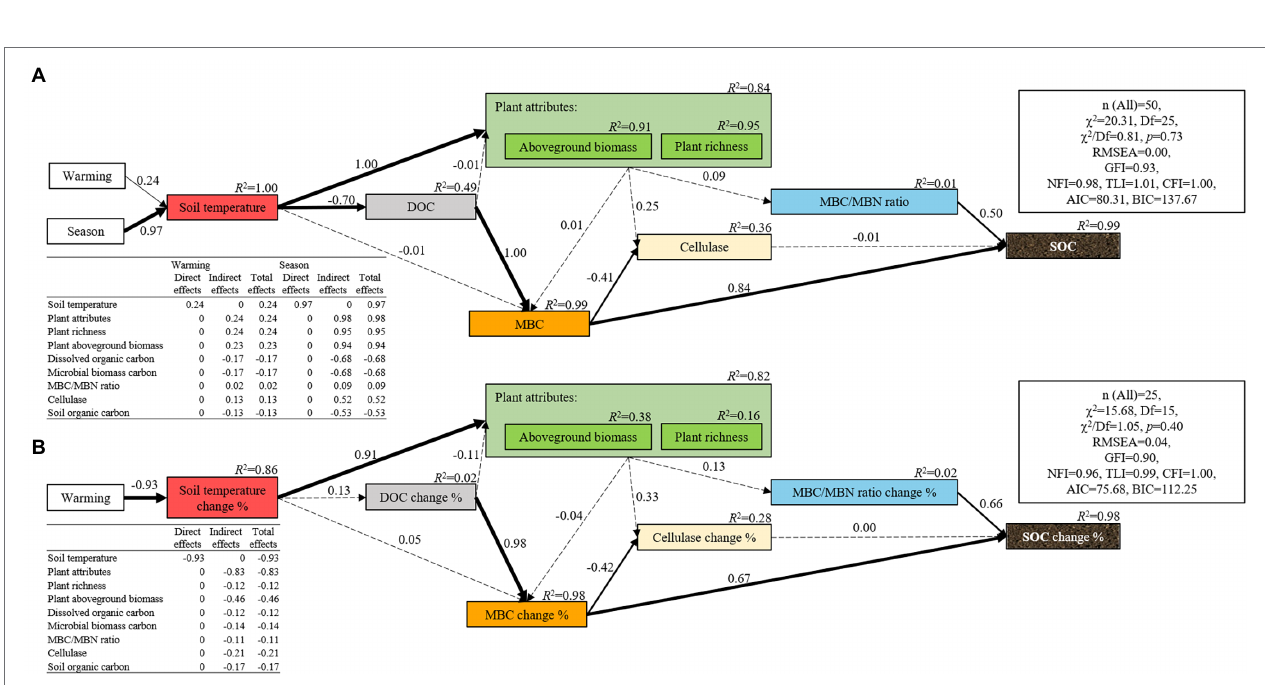
FIGURE 5 | Structural equation model for soil organic carbon (A) and the change of soil organic carbon during the growing season (B) . The thickness of the arrows indicates the strength of the effect, and the number along each arrow represents the coefficient of the path. The dotted lines indicate paths that are not significant. The R 2 value represents the proportion of variance that each variable can